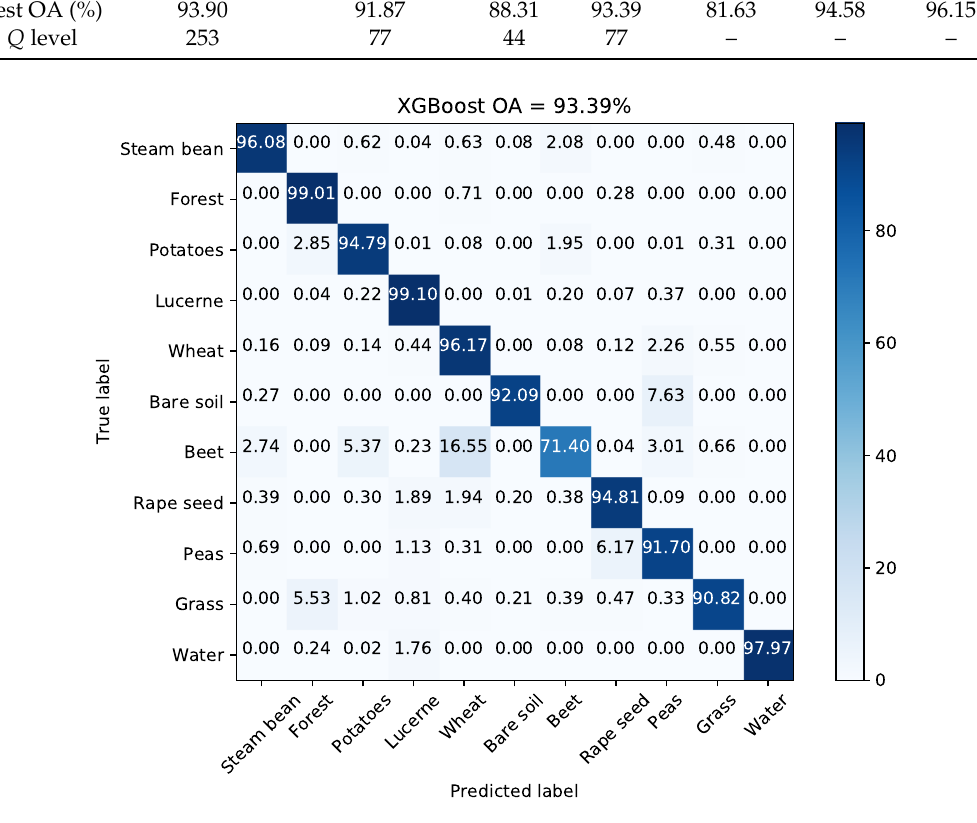
Figure 22. Confusion matrix with the selected Q level for AIRSAR Flevoland data